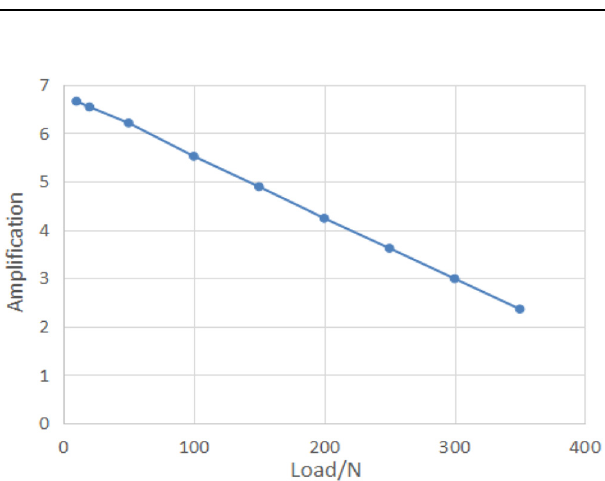
Fig. 11. Relationship between load and ampli fi